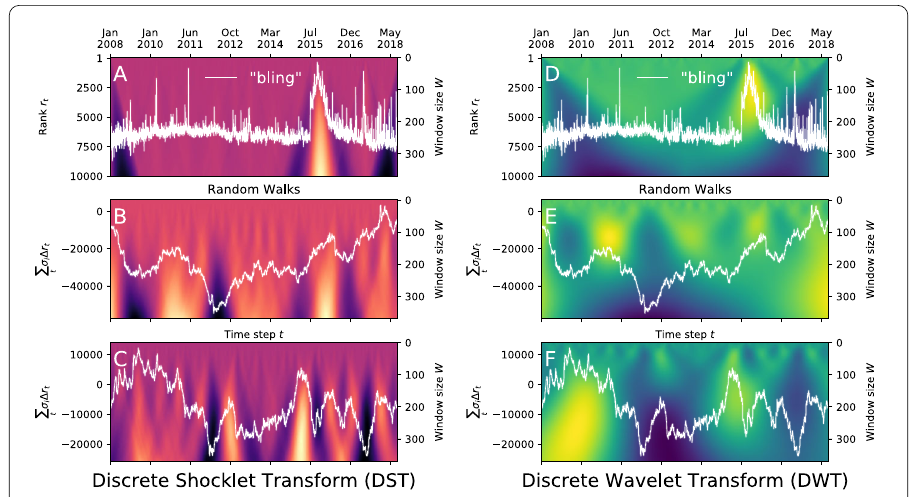
Figure 5 Intricate dynamics of sociotechnical time series. Panels ( A ) and ( D ) show the time series of the ranks down from top of the word “bling” on Twitter. Until mid-summer 2015, the time series presents as random fluctuation about a steady, relatively-constant level. However, the series then displays a large fluctuation, increases rapidly, and then decays slowly after a sharp peak. The underlying mechanism for these dynamics was the release of a popular song titled “Hotline Bling”. To demonstrate the qualitative difference of the “bling” time series from draws from a null random walk model, the details of which are given in Appendix 1. Panels ( A ), ( B ), and ( C ) show the discrete shocklet transform of the original series for “bling” and the random walks (cid:4) (cid:6) r σ it , showing the responsiveness of the DST to nonstationary local dynamics and its insensitivity to t (cid:9)≤ t dynamic range. Panels ( D ), ( E ), and ( F ), on the other hand, display the discrete wavelet transform of the original series and of the random walks, demonstrating the DWT’s comparatively less-sensitive nature to local shock-like